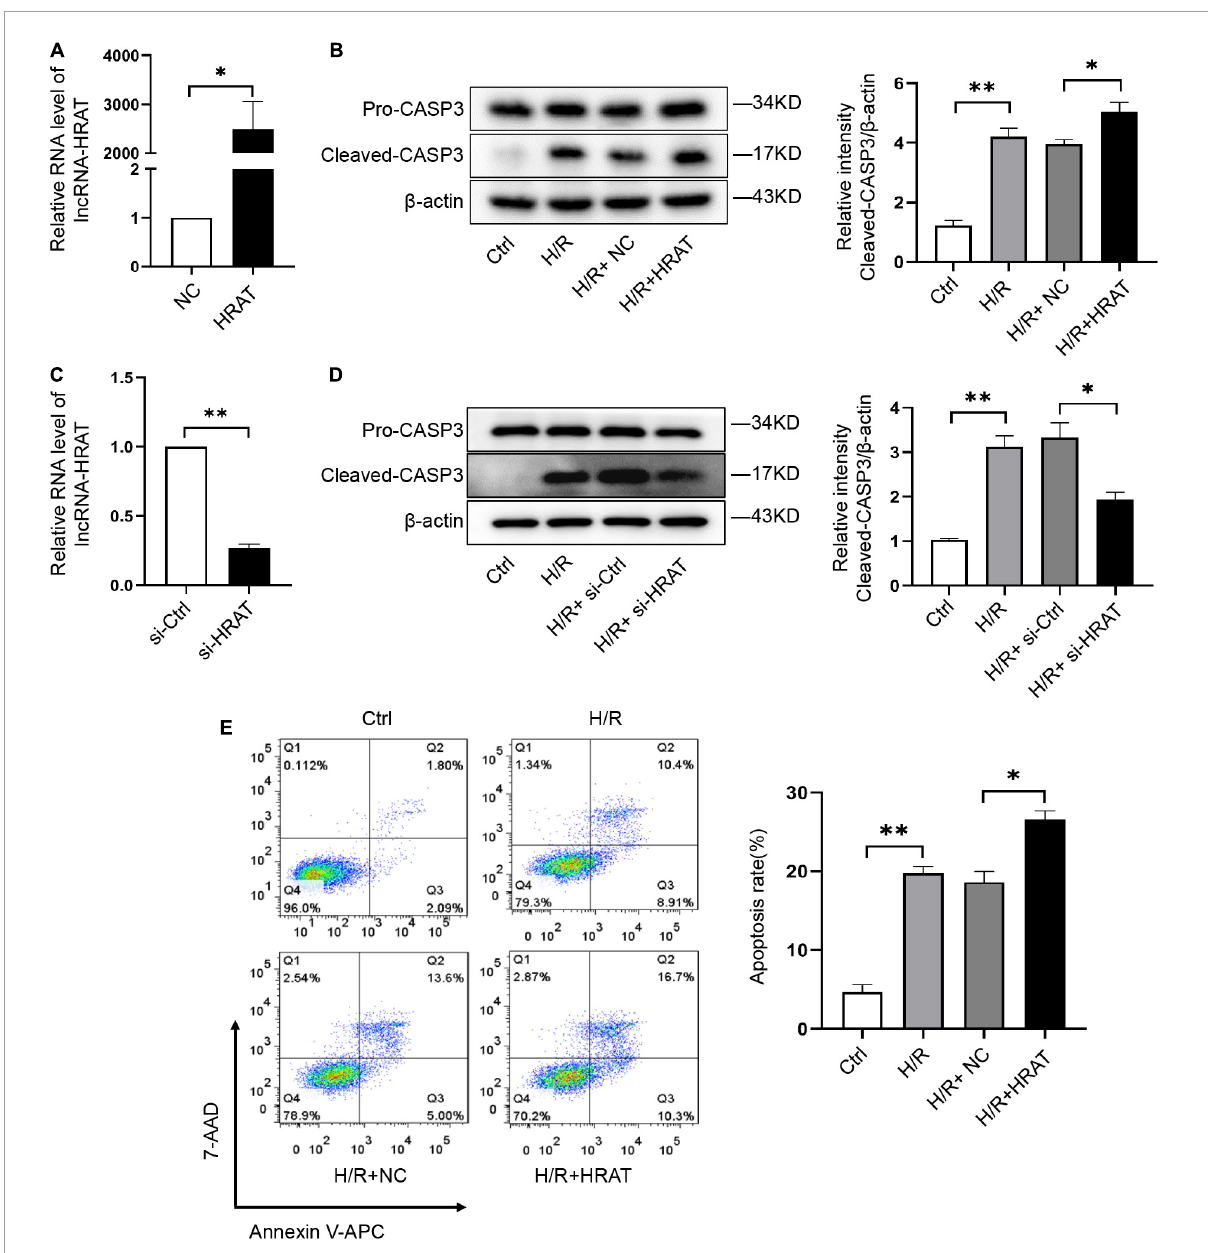
FIGURE2 LncRNA-HRAT overexpression exacerbates the apoptosis induced by H/R in cardiomyocytes. (A) The analysis of lncRNA-HRAT expression in H9c2 cells infected with lncRNA-HRAT or control lentivirus was conducted through qRT-PCR ( n = 3). (C) The analysis of lncRNA-HRAT expression in H9c2 cells transfected with lncRNA-HRAT or control siRNA was conducted through qRT-PCR ( n = 3). (B,D) Protein levels of caspase-3 and cleaved-caspase-3 in different groups of cells were tested via Western blot ( n = 3). (E) The apoptotic cell rate in H9c2 cells was measured through flow cytometry ( n = 3). The data are described as mean ± SD. * P < 0.05, ** P <